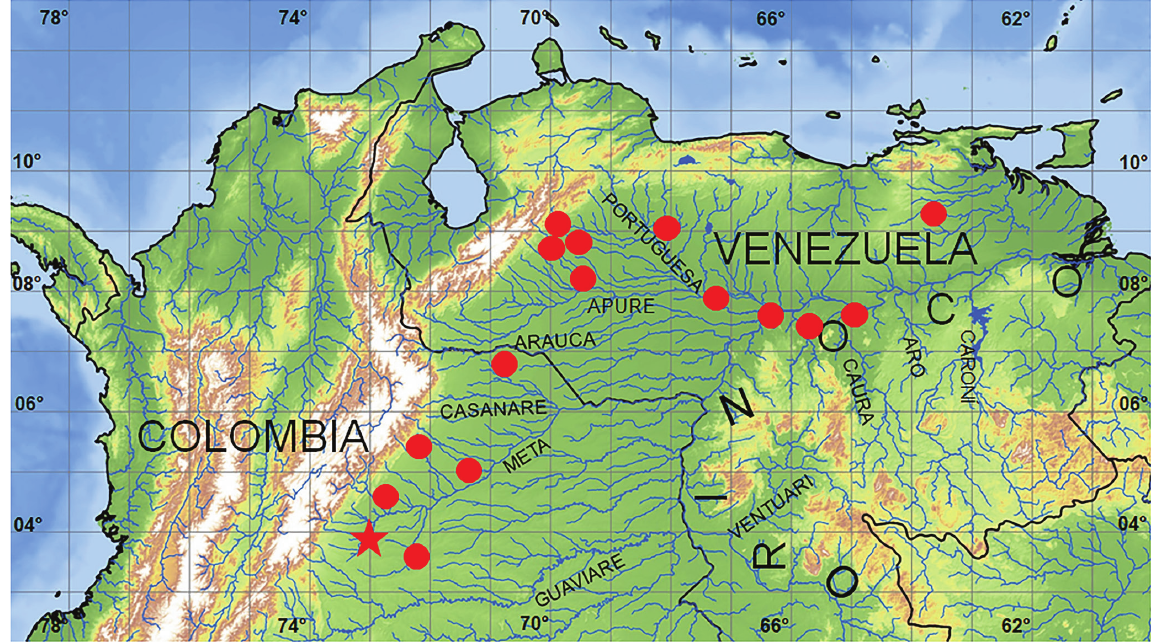
Fig. 5. Map of northern South America (Colombia and Venezuela) showing capture localities of Pseudohemiodon unillano , red star is type locality, some symbols may represents more than one